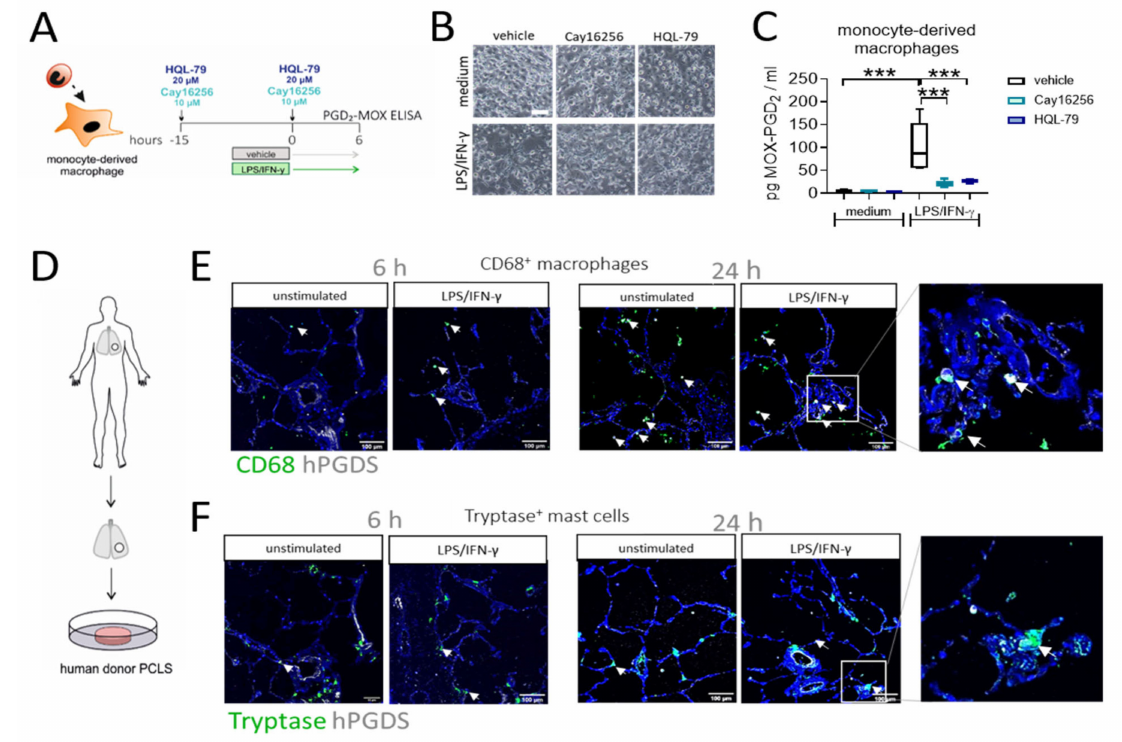
Figure 6. Inhibition of hPGDS prevents PGD 2 production by human monocyte-derived macrophages and CD68 + phagocytes strongly express hPGDS in human lung tissue. ( A ) Human monocyte-derived macrophages were incubated with hPGDS inhibitors or vehicle overnight and stimulated with LPS/IFN- γ in the presence of inhibitors for 6 h. ( B ) Monocyte-derived macrophages at the time of collection (representative of n = 4 donors; scale bar 100 µ m). ( C ) hPGDS inhibitors Cay16256 (10 µ M) and HQL-79 (20 µ M) significantly reduced PGD 2 production by macrophages. ( D ) Serial cut precision-cut lung slices (PCLS) from human lung tissue resections were used. ( E ) Co-staining of CD68 and hPGDS showed that macrophage- like cells already express hPGDS in unstimulated PCLS and to a stronger extent in LPS/IFN- γ -treated PCLS. ( F ) hPGDS + tryptase + mast cells were present in donor PCLS, but hPGDS levels were less pronounced compared to macrophages and unaffected by stimulation with LPS/IFN- γ . Data are shown as box-and-whisker plot, n = 5. One-way ANOVA for repeated measurements (mixed model) with Sidak’s post hoc test, *** p <